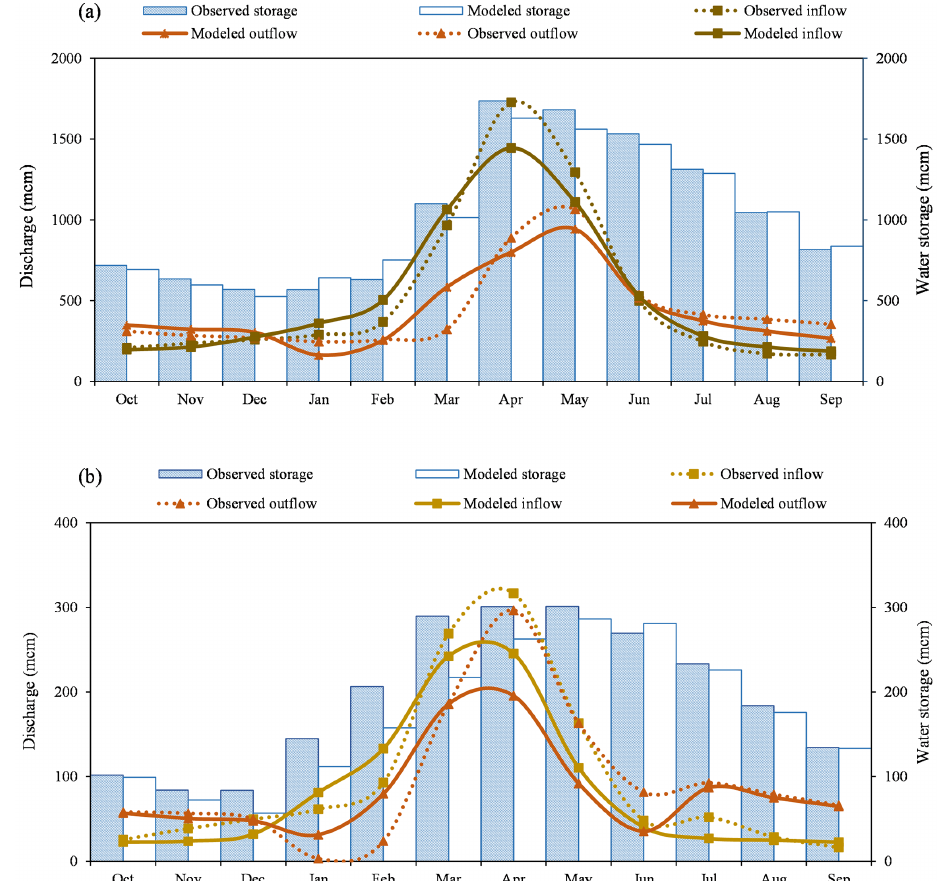
Figure 5. Mean observed and modeled inflow, outflow, and storage volume at (a) the Kajakai and (b) Dahla Dam reservoirs during the 1970–1979